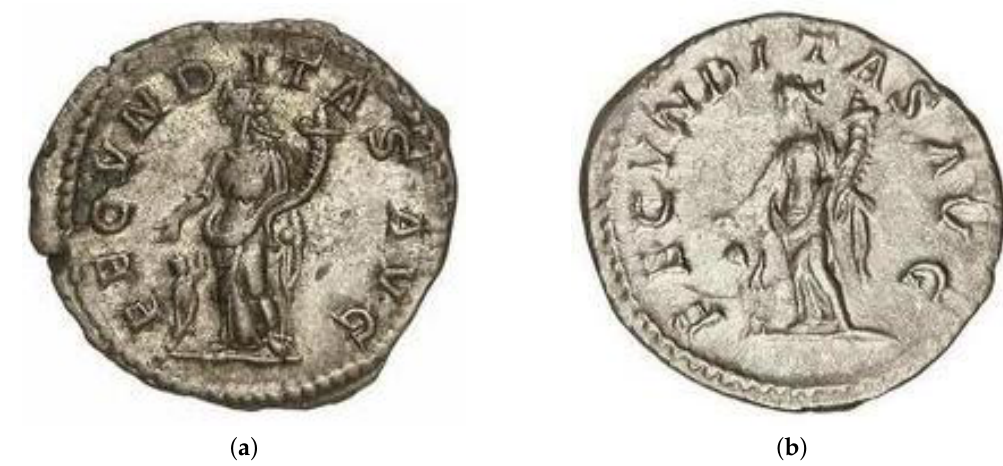
Figure 2. Reverses of two different specimens of the same issue—a silver (AR) denarius of Julia Maesa (RIC 249). Despite them being the same issue, the two specimens exhibit a series of appearance differences. These range from the arrangement of legend letters (e.g., note that the ‘I’ in ‘FECVNDITAS’ is to the left—as seen by a reader—of the goddess depicted on the specimen in ( a ) and to the right in ( b )), the exact pose of the child next to the goddess (Fecunditas) or indeed the goddess herself, the flan shape and the centering of the motif within the flan, the damage and loss of fine detail, and the toning (‘color’ change). Denomination categorization is a classification problem which, as the name suggests, is